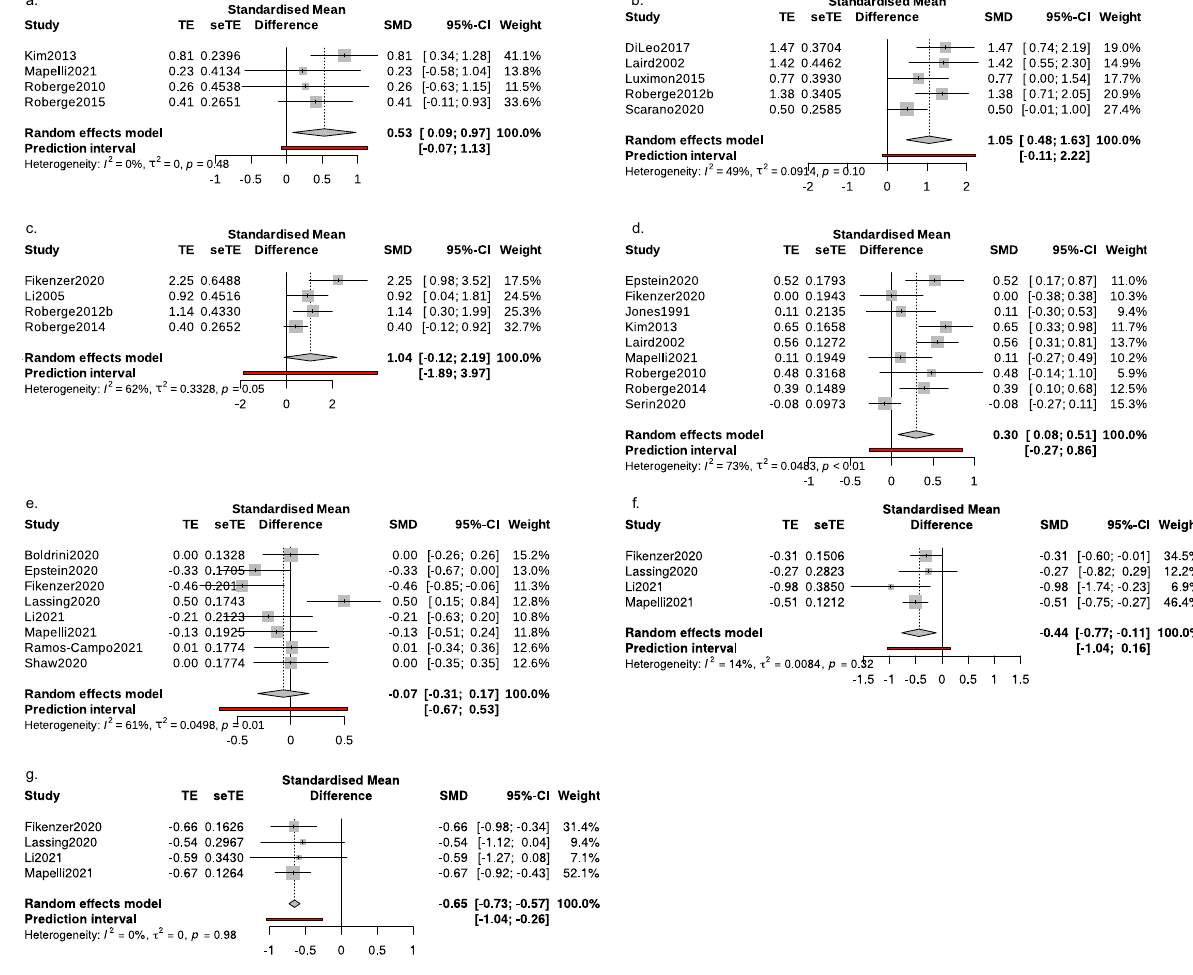
Figure 3. Statistically significant pairwise comparisons; Effect of N95 filtering facepiece respirators on ( a ) transcutaneous carbon dioxide pressure, ( b ) temperature of facial skin covered by the mask, ( c ) subjective rating of heat perception, ( d ) heart rate. Effect of surgical mask on: ( e ) respiratory rate, ( f ) VO 2max /kg and ( g ) VE during high intensity